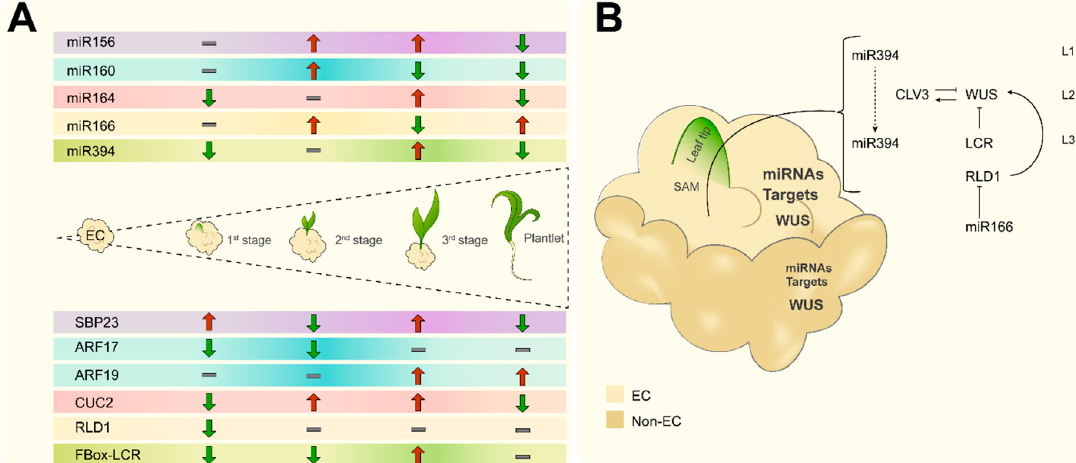
Figure 6. Proposed model for miRNA-target action during in vitro maize VS-535 Tuxpeño plant regeneration. ( A ) Maize VS-535 in vitro plant regeneration occurs in a basipetal way with the most noteworthy miRNA-target accumulation switches taking place at the 2nd and 3rd stages of regeneration. Opposite patterns between miRNA and targets are observed at these stages. ( B ) Distinctive miRNA-target accumulation between EC and Y-NEC (greater accumulation corresponds to bigger letter size) underlies the ability to develop regenerative structures under the appropriate stimulus. A highlighted node corresponds to miR394, which is proposed to relocate and negatively regulate LCR resulting in WUS spatial restriction and stem cell identity acquisition in SAM upon the regeneration stimulus. Likewise, miR166 participates as mobile signal for proper SAM maintenance and spatially restricts the localization of HD-ZIP III transcription factors at the shoot apex to establish polarity in the emerging leaf. Cell layers (L1–L3) and additional WUS regulation by CLAVATA (CLV3) are depicted according to the literature [42,43].